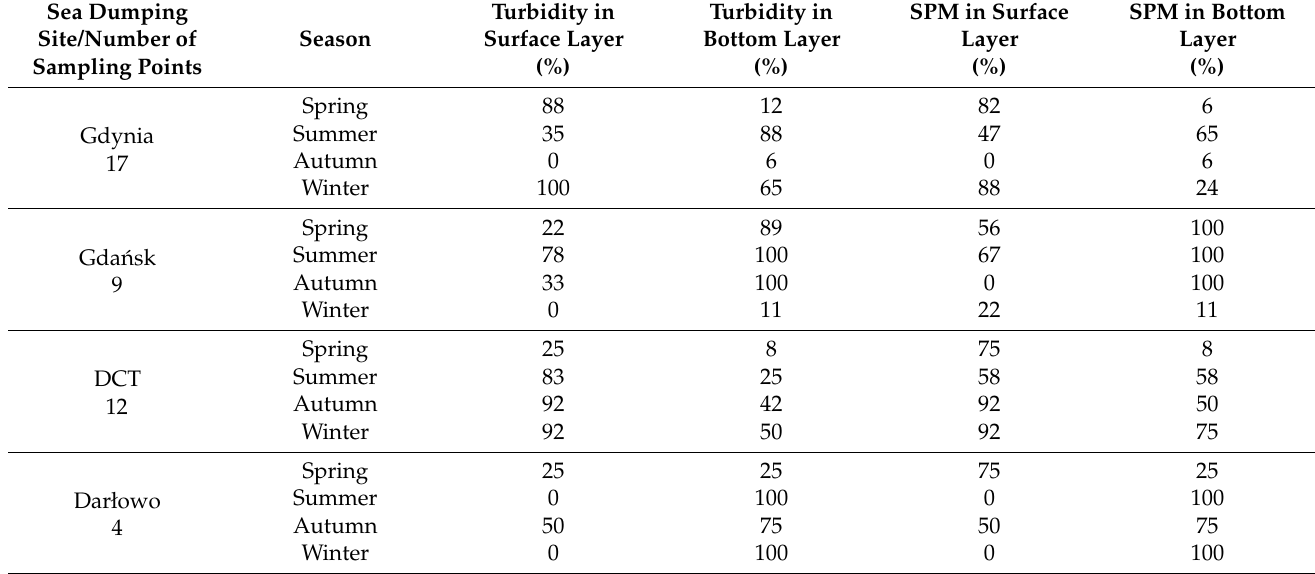
Table 4. Percentage of measurement points where the results of turbidity and SPM concentration exceeded those obtained for the reference